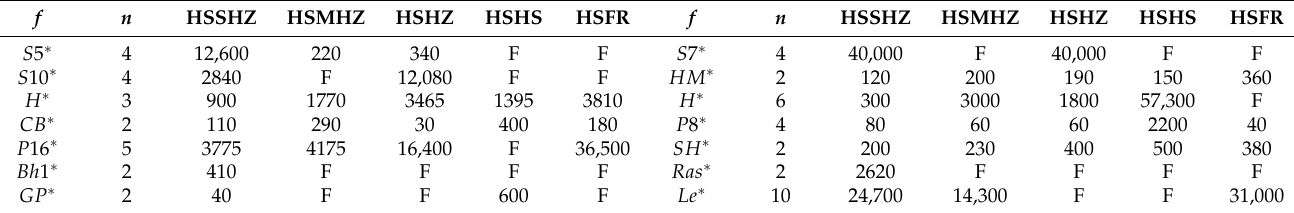
Table 10. The number of worst function evaluations.